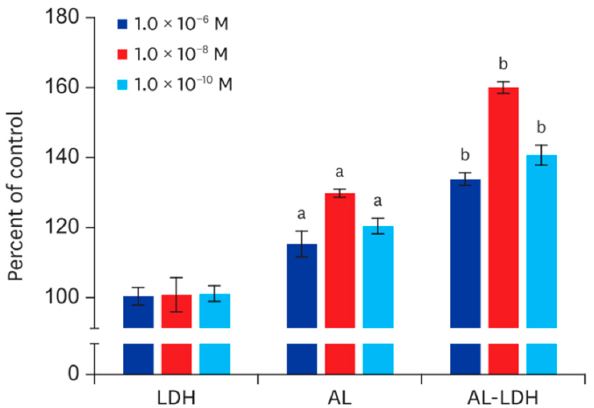
Figure 17. Experimental results showing the biocompatibility of pristine MgAl LDHs